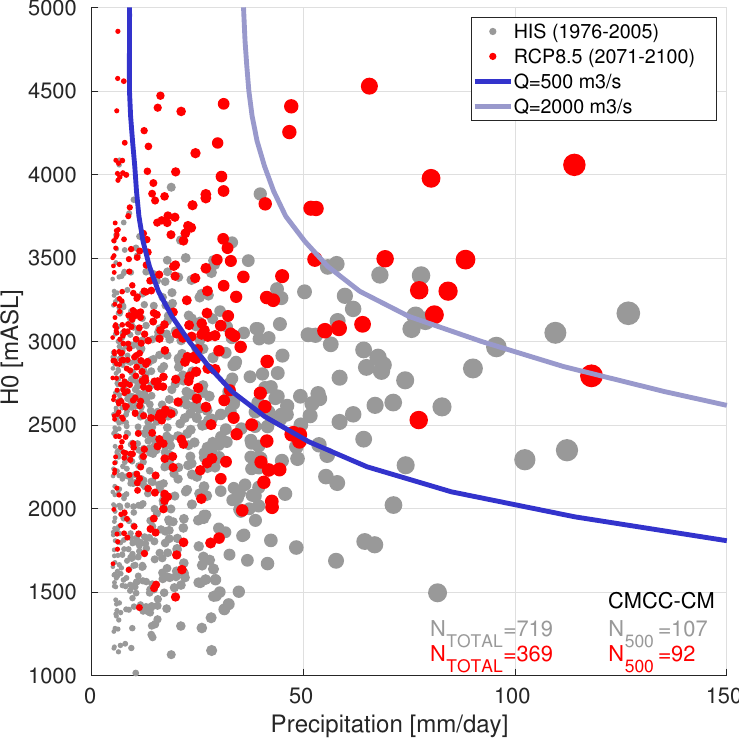
Figure 10. Scatter plot between CMCC-CM simulated daily precipitation and H 0 for wet days in Santiago (model closest point) considering the historical period (1976–2005, gray circles) and the end of century (2071–2100 under RCP8.5, red circles). The light blue line represents the combination of precipitation and H 0 values resulting in a discharge of 500 m 3 /s (2000 m 3 /s) in at the outlet of the upper Maipo river basin using the simplest hydrological model (Section 4.3). The number of total rainy days ( N total ) and those resulting in more than 500 m 3 /s ( N 500 ) are